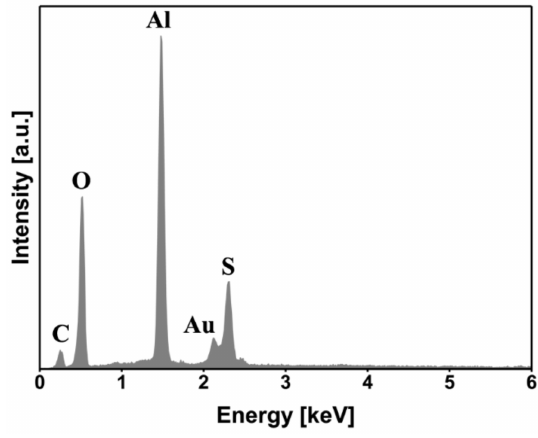
Figure 19. EDS area analysis of the fracture surface shown in Figure